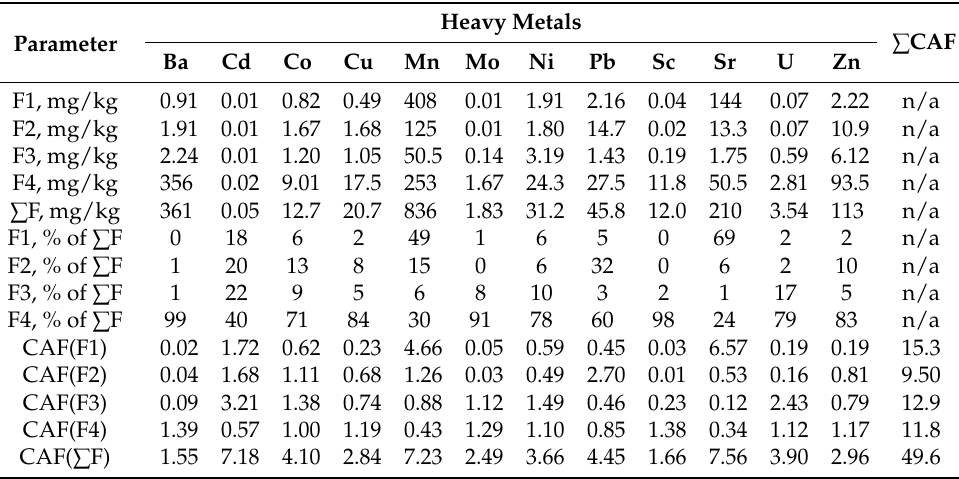
Table 2. Results of HMs fractionation in surface sediments of Daya Bay and levels of chemical affinity factor (CAF)—calculated from the data of X. Gao et al.